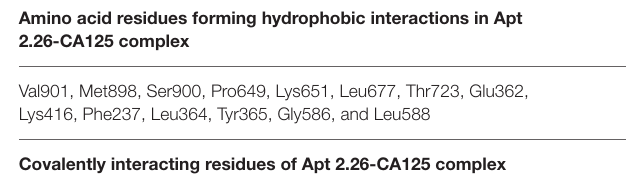
TABLE 2 | Binding scores of aptamer candidates with CA125, BSA, HSA, and IgG.